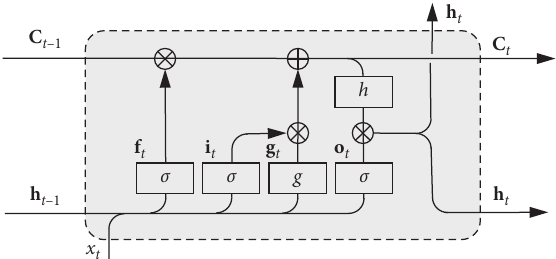
Figure 2: Internal structure of the LSTM